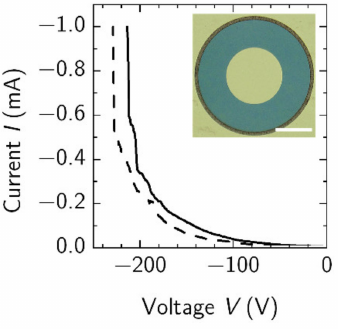
Figure 7. Breakdown of two SBDs with contact spacings of 5 µ m (solid line) and 40 µ m (dashed line). Current was limited to 1 mA level. Inset–microscope image of the SBD with diameter of central Schottky contact and distance to ohmic contact being of 80 µ m and 40 µ m,